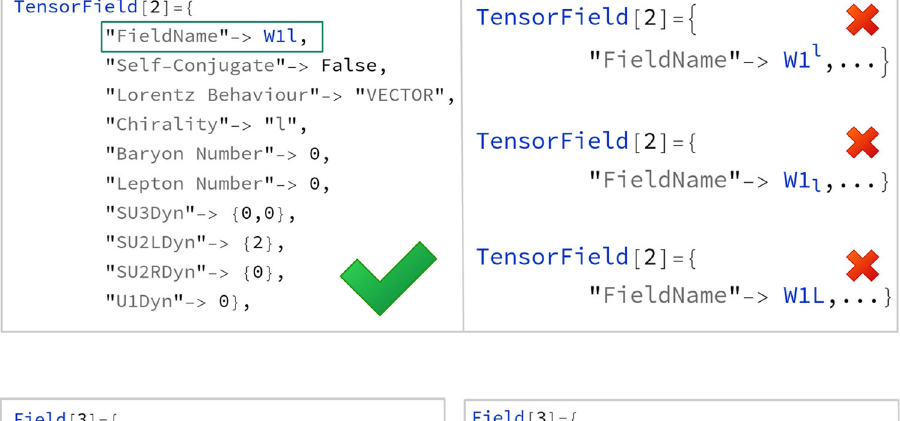
how one should not name the groups in describing the particle transformation